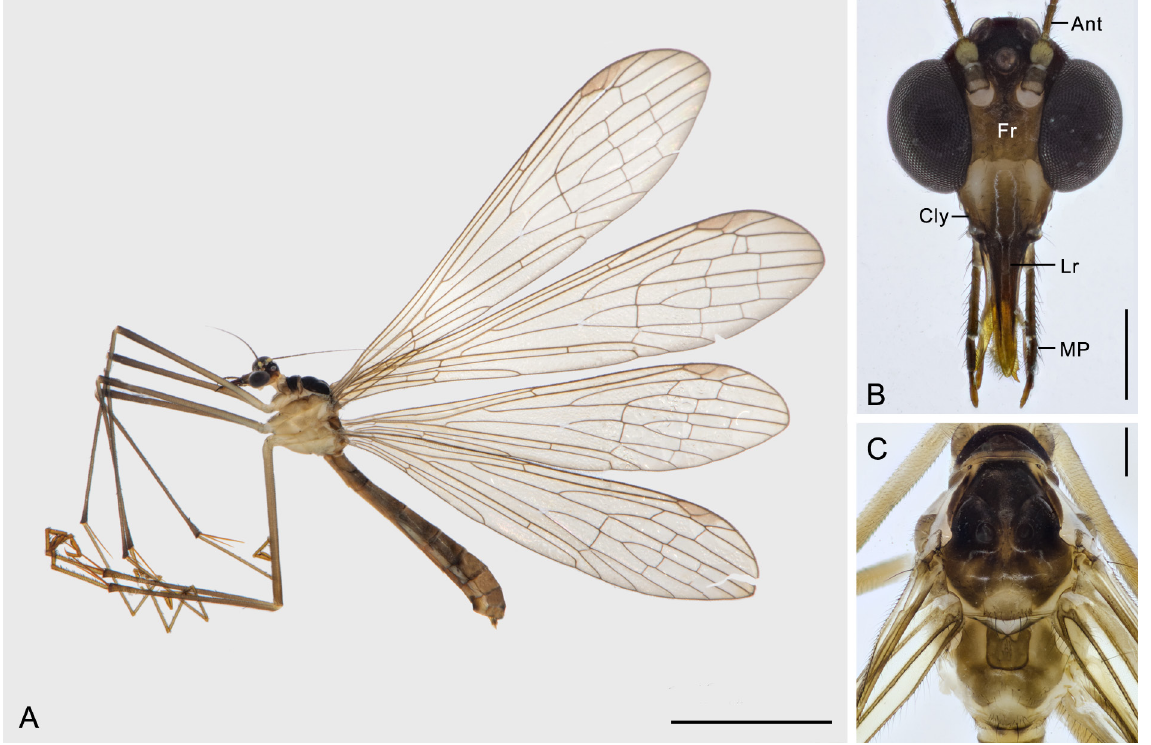
Fig. 1. Terrobittacus rostratus sp. nov. A . ♀, habitus in lateral view. B . Head in frontal view. C . Thorax in dorsal view. Abbreviations: Ant = antenna; Cly = clypeus; Fr = frons; Lr = labrum; MP = maxillary palp. Scale bars: A = 5.0 mm; B–C = 0.5